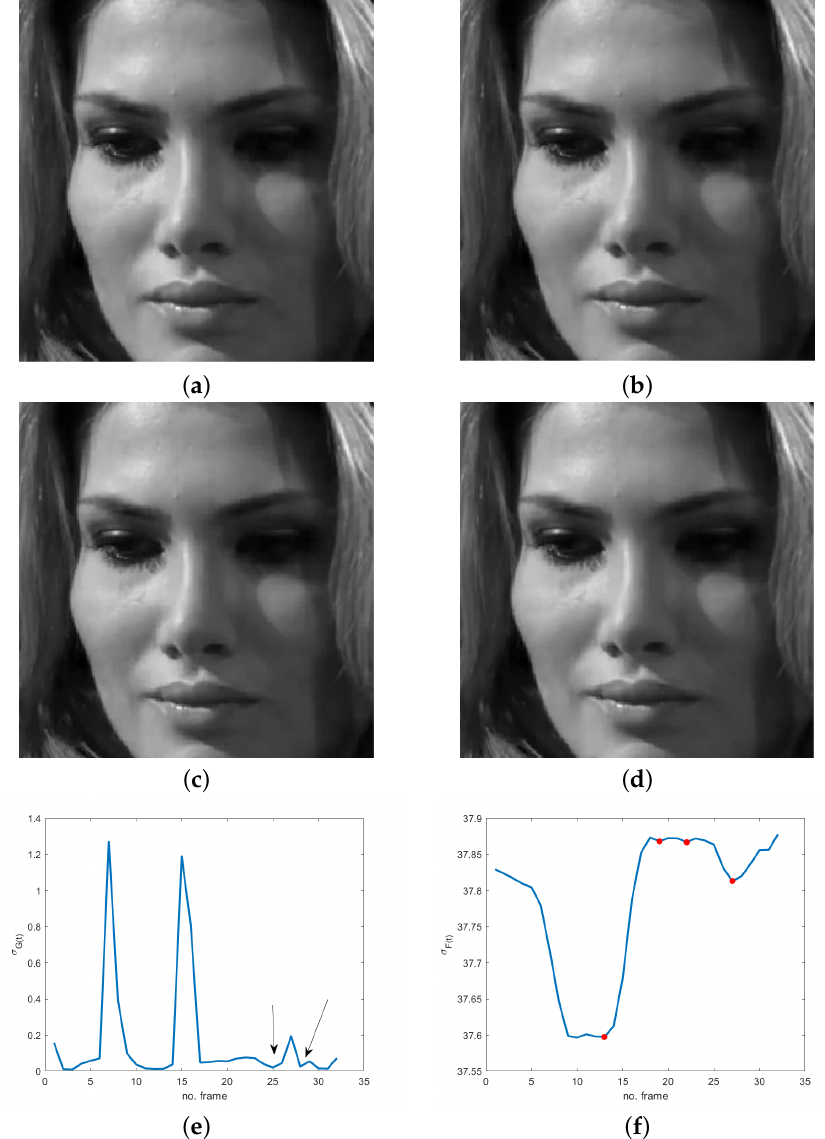
Figure 4. Four frames of the sequence cut 14.3 from the MEVIEW dataset [38]: ( a ) frozen frame before ME (happy); ( b ) ME onset; ( c ) ME apex; ( d ) frozen frame after ME; ( e ) temporal global energy measured as the standard deviation of the spatio-temporal filtered sequence using the filter in Equation (1)—the arrows indicate frozen frames; ( f ) standard deviation of the spatio-temporal filtered sequence using the filter l ( x , y , t ) in Equation (2) restricted to the group of frames containing the ME—markers correspond to local